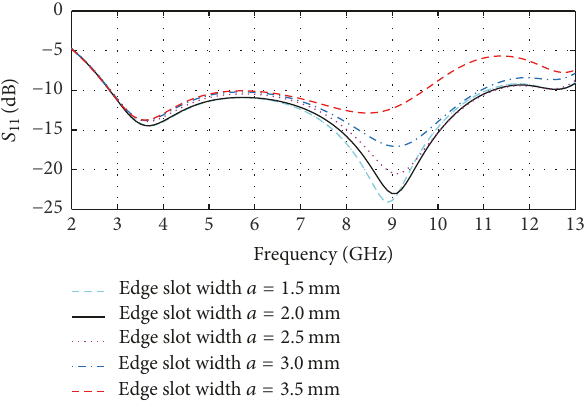
Figure 7: Effect of edge slots width on impedance bandwidth.